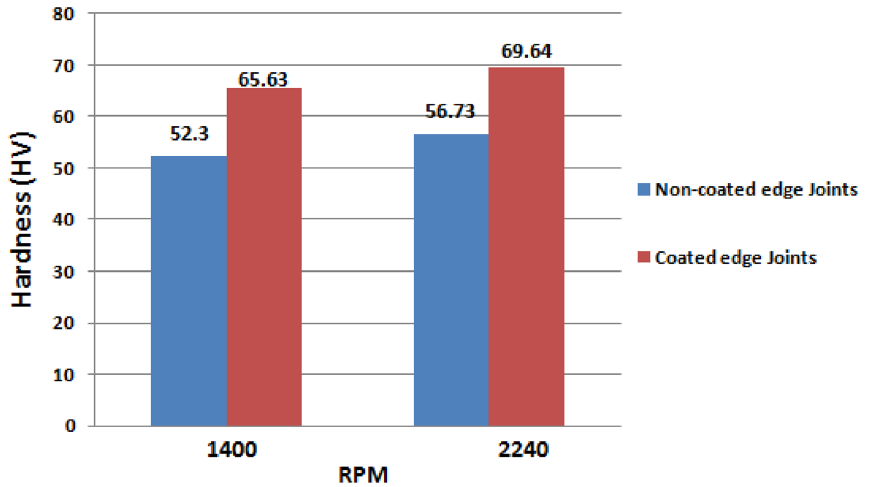
Figure 17. Hardness of welded